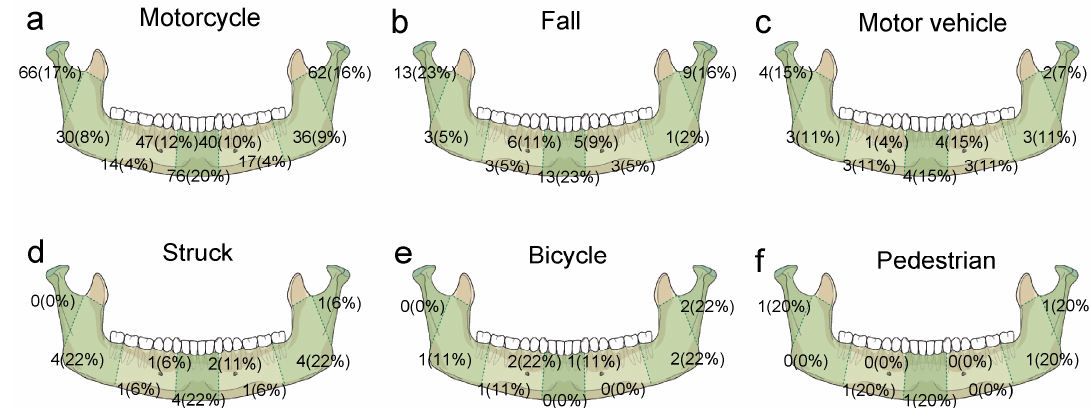
Figure 1. Numbers and percentage of patients per fracture sites of the mandible caused by different trauma. ( a ) motorcycle; ( b ) fall; ( c ) motor vehicle; ( d ) struck; ( e ) bicycle; ( f ) pedestrian.